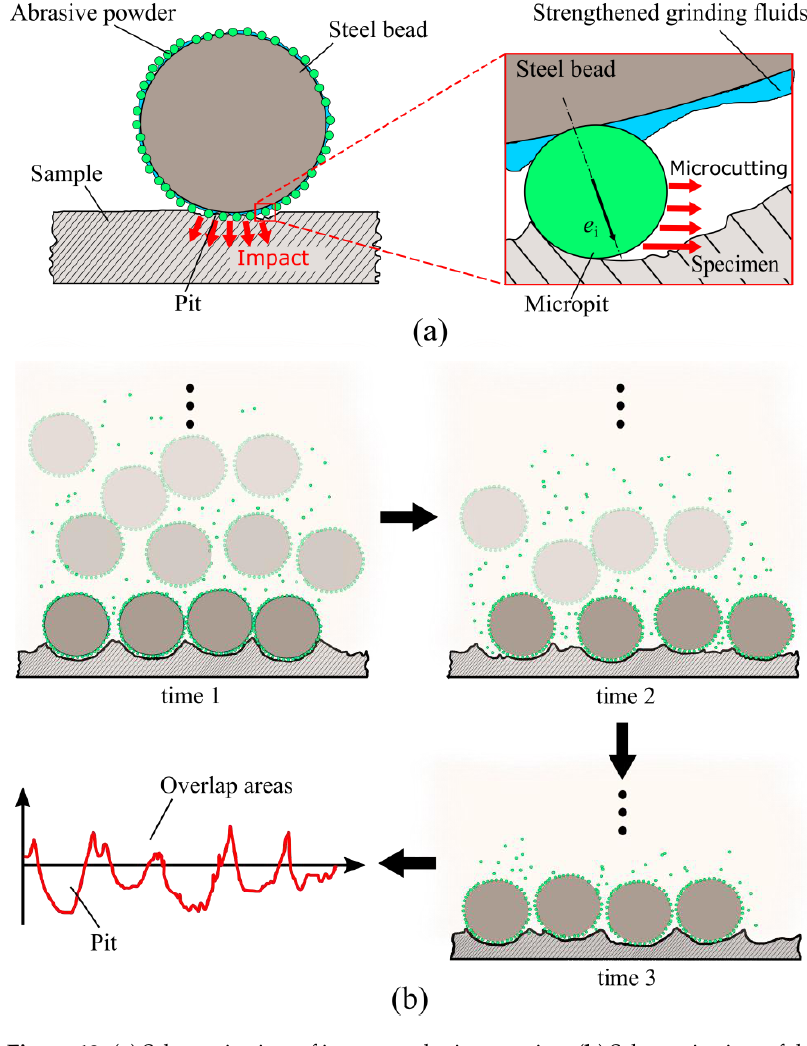
Figure 13. ( a ) Schematic view of impact and micro-cutting; ( b ) Schematic view of the two-dimensional profile.